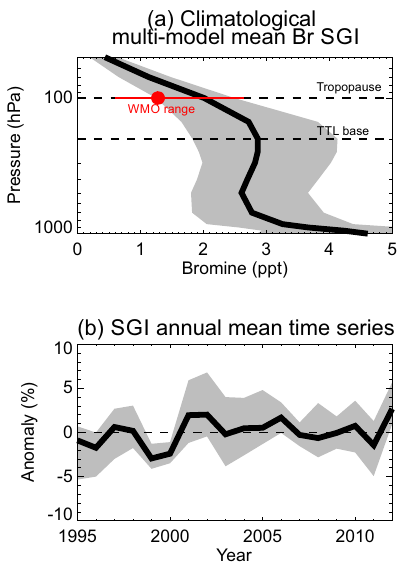
Figure 16. (a) Climatological multi-model mean source gas injection of bromine (ppt) from CHBr 3 and CH 2 Br 2 (i.e. [3 × CHBr 3 ] + [2 × CH 2 Br 2 ] mixing ratio). The shaded region de- notes the model spread. The best estimate (red circle) and SGI range from these gases (based on observations) reported in the most re- cent WMO O 3 Assessment Report (Carpenter and Reimann, 2014) are also shown. (b) Time series of multi-model mean stratospheric bromine SGI anomalies. Anomalies are calculated as the departure of the annual mean from the climatological mean